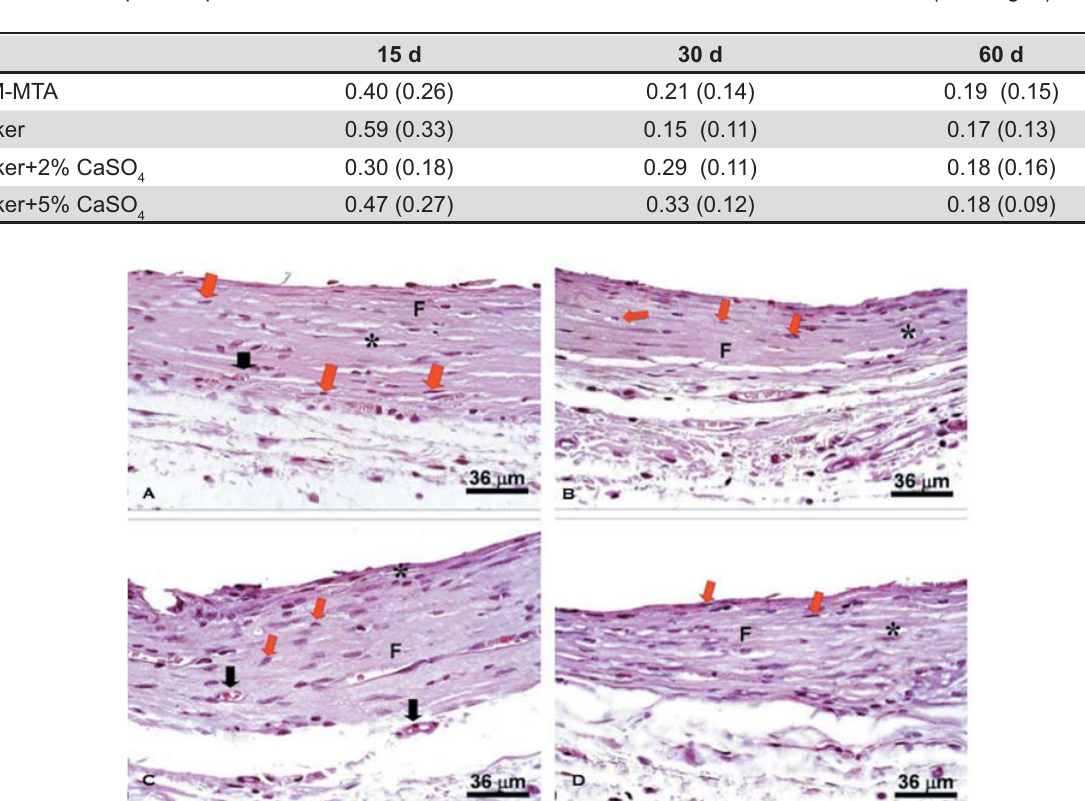
Figure 1- Subcutaneous tissue response at 60 days at capsular tissue (*). Pure clinker cement (A), White Portland